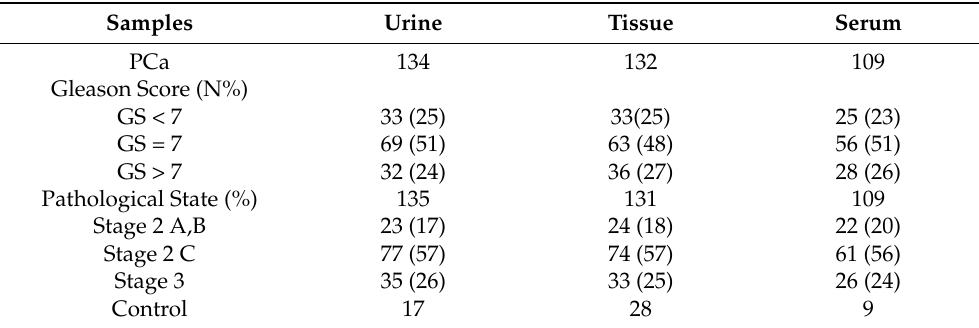
Table 3. Characteristic of groups in reference to morphological evaluation according to the Glea- son scale (GS) and pTNM stage assessment (B) characteristic of population in the two groups. PCa = prostate cancer cases and BPH = benign prostatic hyperplasia.